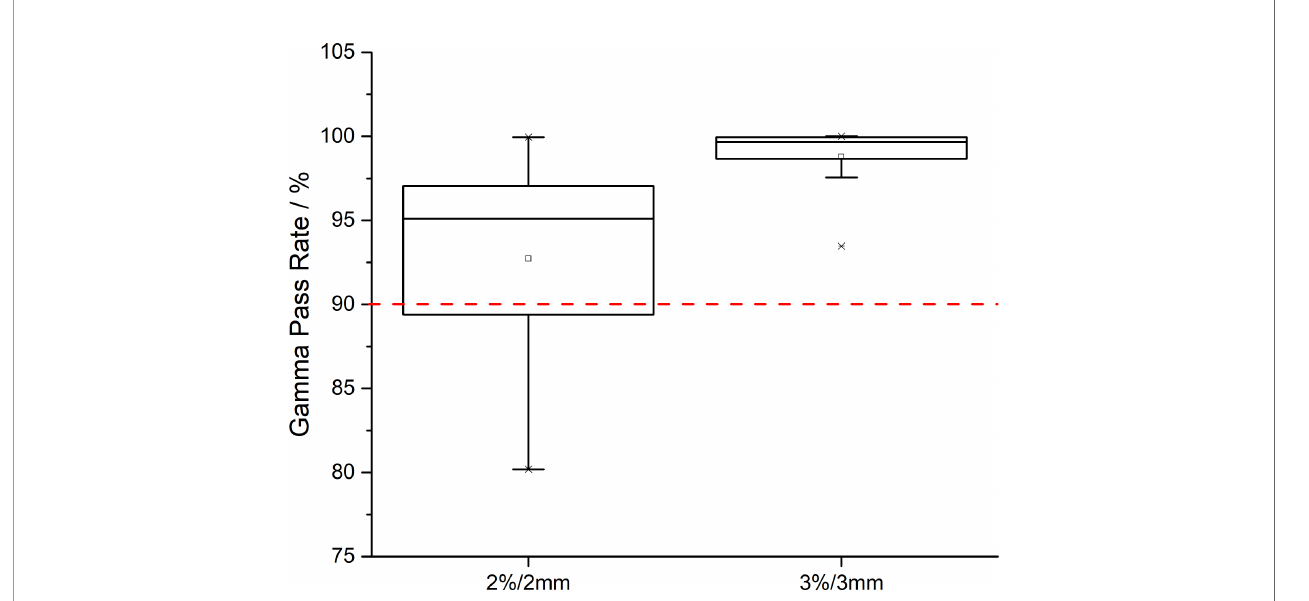
FIGURE 4 | The correspondence between the AS-VMAT plans and the MS-VMAT plans in terms of gamma passing rates in clinical target volume (CTV). The red dotted line denotes a gamma passing rate of 90%. AS-VMAT, automatic segmentations VMAT; MS-VMAT, manual segmentations VMAT.